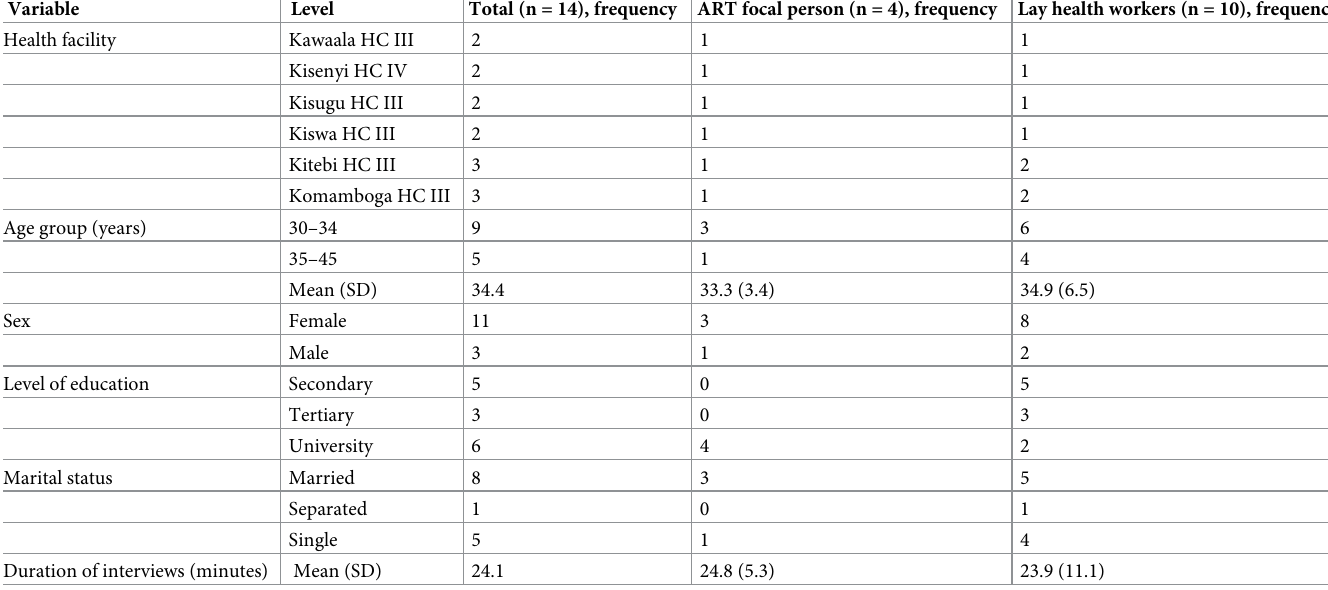
Table 1. Participant